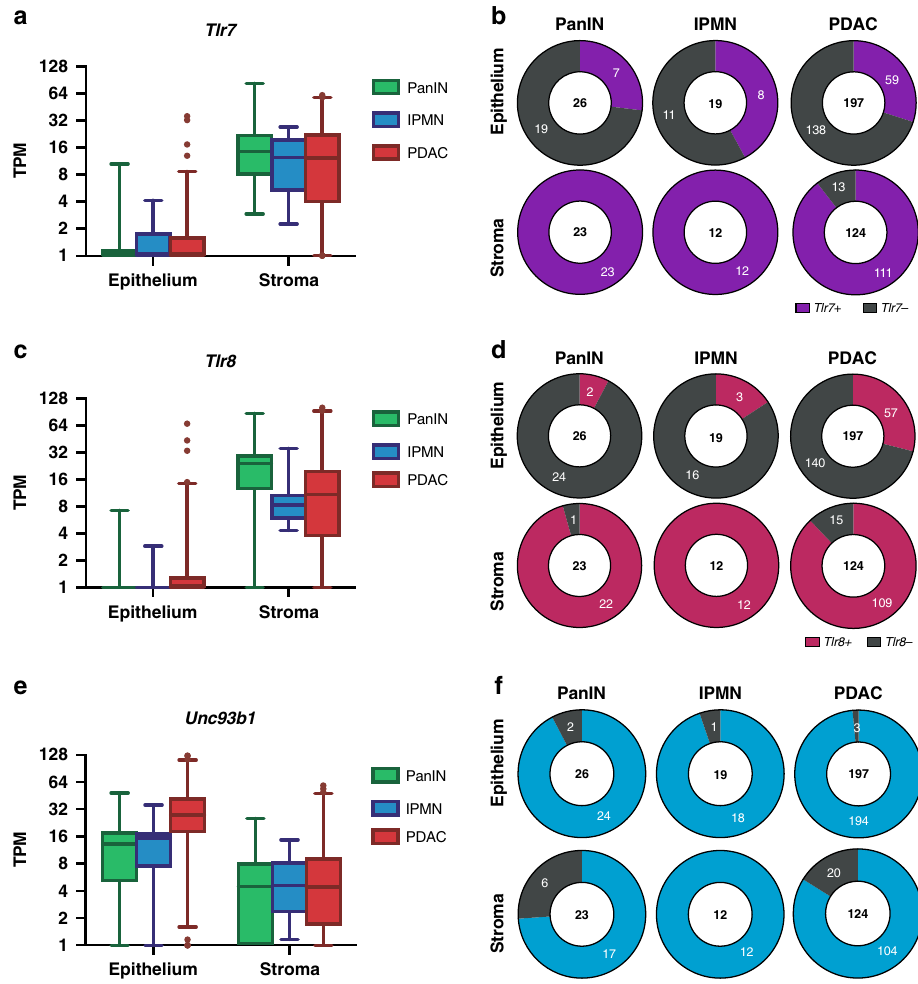
Fig. 7 Tlr7 is common in the stroma but not in the epithelium of human pancreatic neoplasms. Left: Transcript count per million (TPM) from RNA-seq in epithelial and stromal laser capture microdissected samples from PanIN, IPMN, and PDAC samples for Tlr7 ( a ), Tlr8 ( c ), and Unc93b1 ( e ). Data displayed as interquartile range, with whiskers depicting 2.5th – 97.5th perecentile. Right: Proportions of samples positive and negative for Tlr7 ( b ), Tlr8 ( d ), and Unc93b1 ( f ) based on the threshold of 1 TPM. Sample size for each category of neoplasm (PanIN, IPMN, and PDAC) and tumor compartment (epithelium and stroma) are shown in the center of the plot, with the outer values depicting absolute frequency of positive and negative